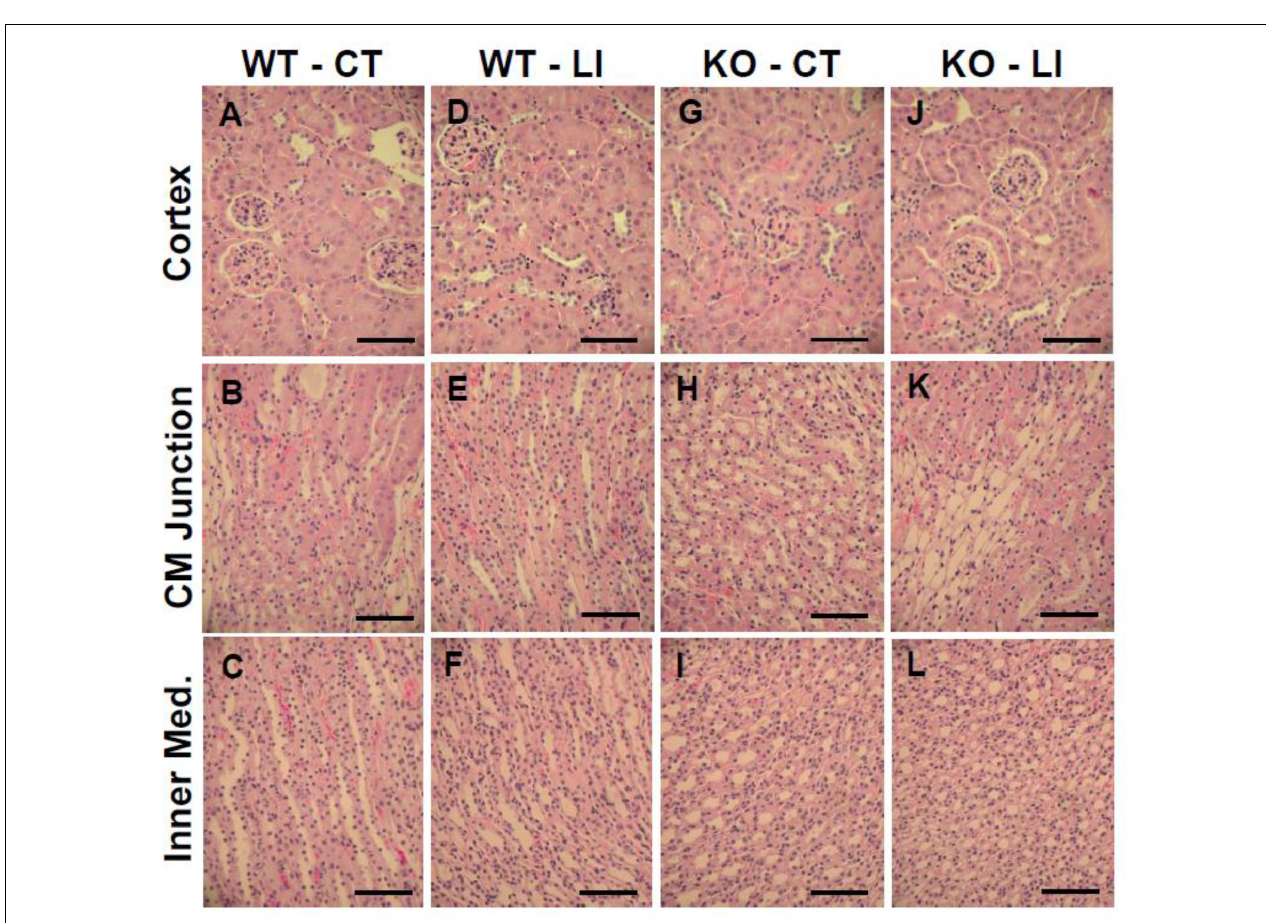
were stained with DAPI (blue). Figure 12 shows